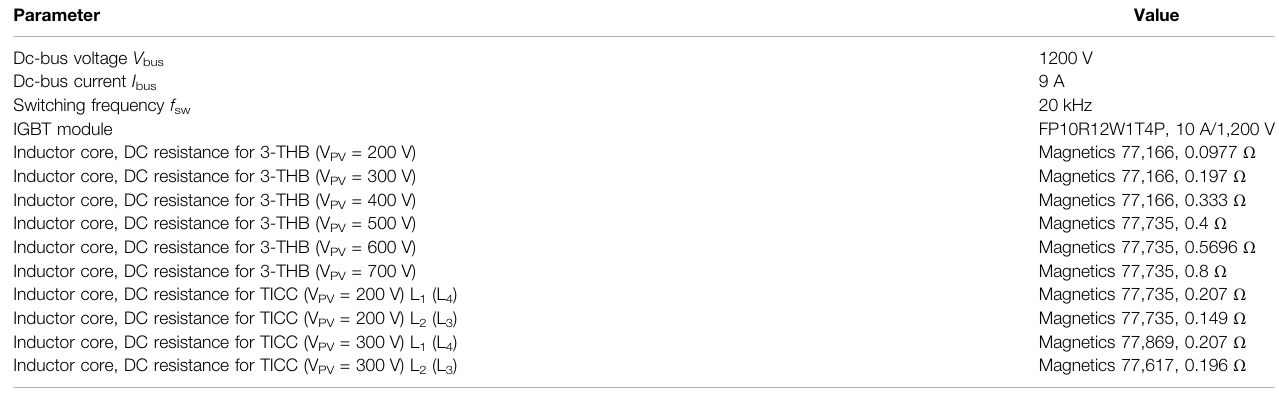
TABLE 5 | Parameters for loss calculation.